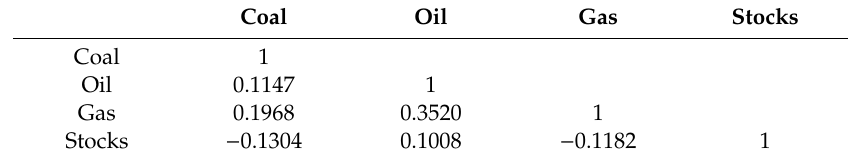
Table 14. Correlations for Italy.